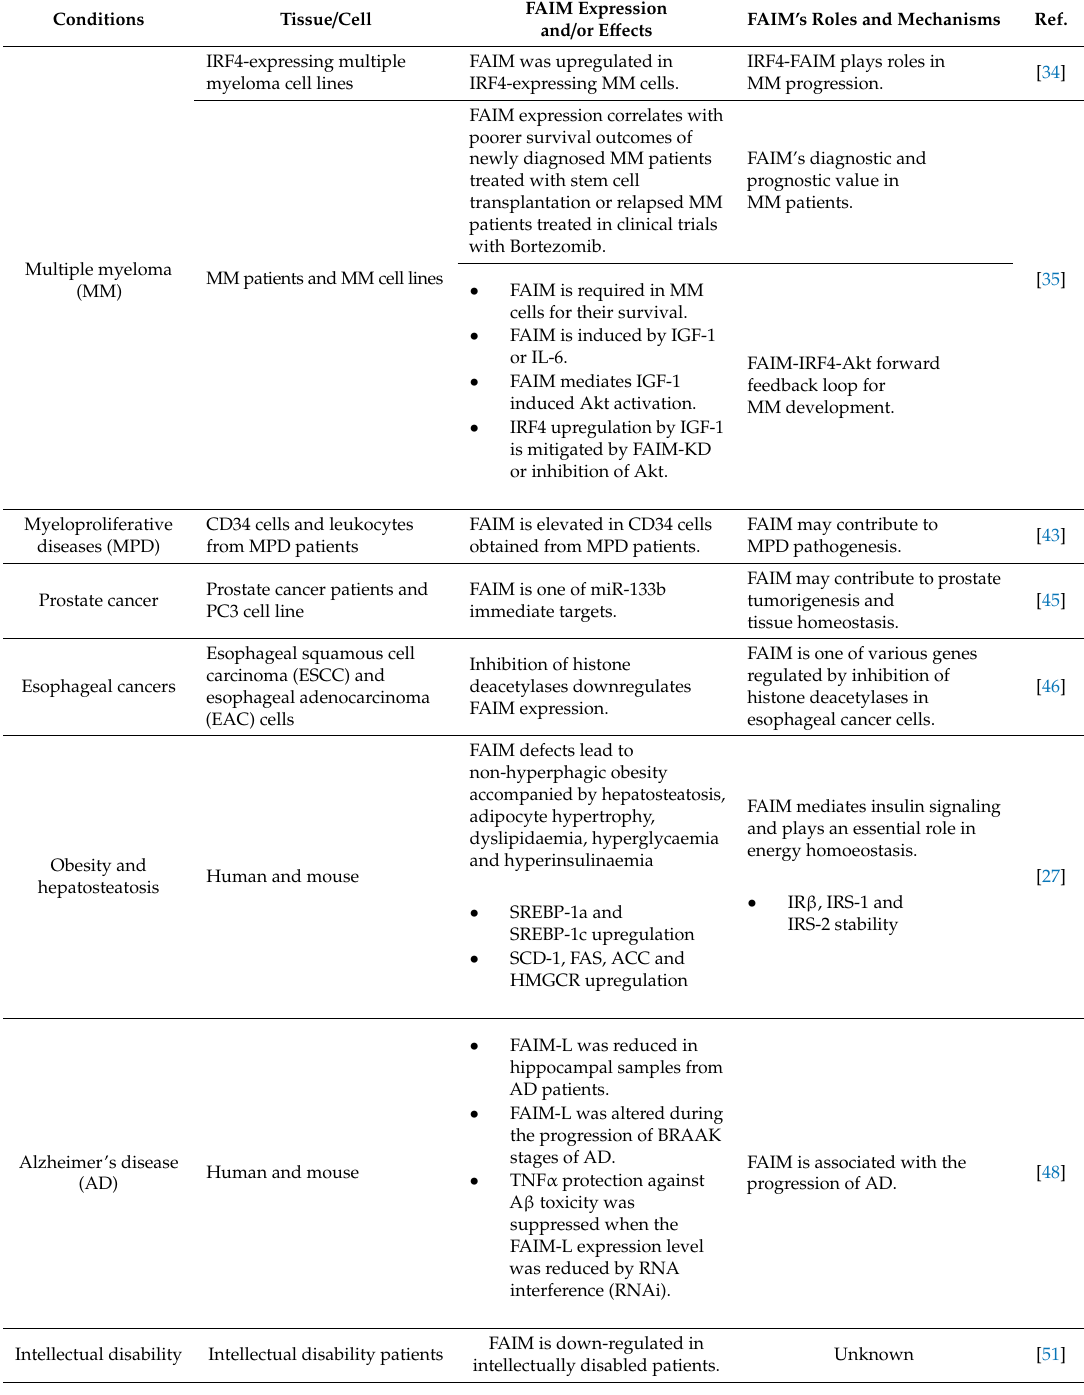
Table 1. Summary of FAIM’s involvement in